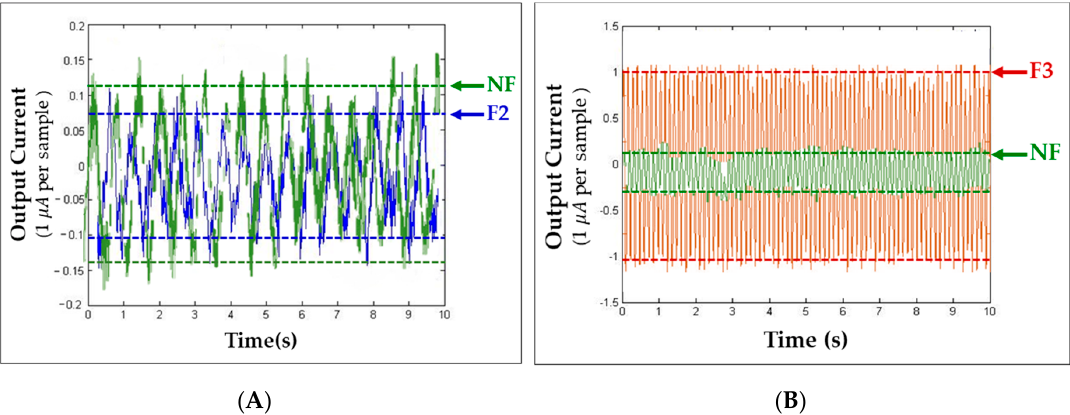
Figure 15. Comparison of output current corresponding to time: ( A ) NF and F2 (1.6 Hz, 1 V); ( B ) NF and F3 (8 Hz, 1 V).